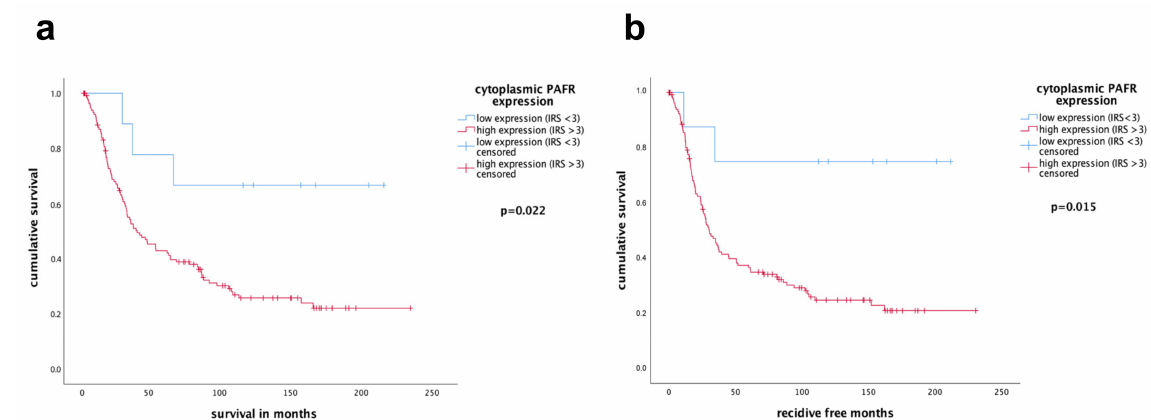
Figure 2. PAFR expression is a prognostic factor in ovarian cancer patients. ( a ) Overall and ( b ) recurrence-free survival of patients whose tumors expressed cytoplasmic PAFR at high levels was compared to those with low PAFR expression by the log rank test. Kaplan–Meier survival plots were drawn. Ovarian cancer patients with elevated PAFR expression in the cytoplasm survived significantly shorter ( a ) and demonstrated a shorter recurrence-free survival time ( b ) compared to the group of patients with low PAFR expression.